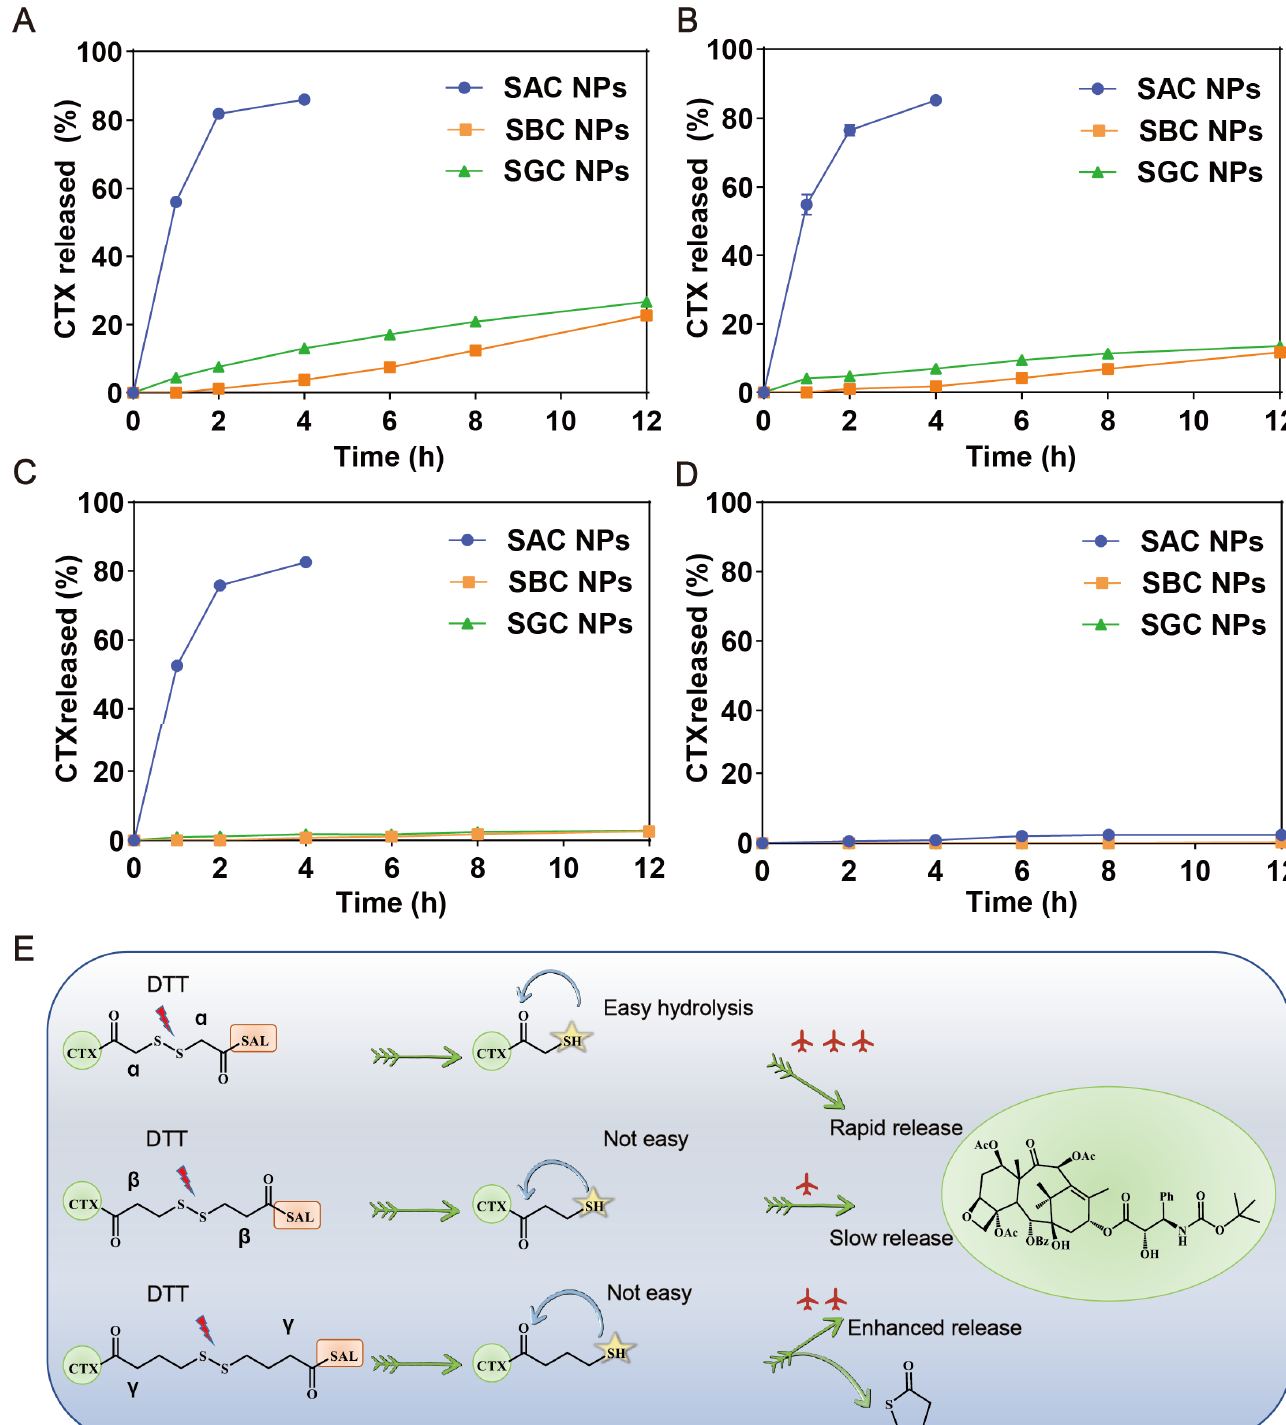
Figure 2. In vitro reduction-responsive drug release of NPs. Drug release of SAC NPs, SBC NPs and SGC NPs from 10 mM DTT ( A ), 5 mM DTT ( B ), 1 mM DTT ( C ) and 0 mM DTT ( E ) ( n = 3); ( D ) Reduction-responsive mechanism of SAC, SBC and SGC.